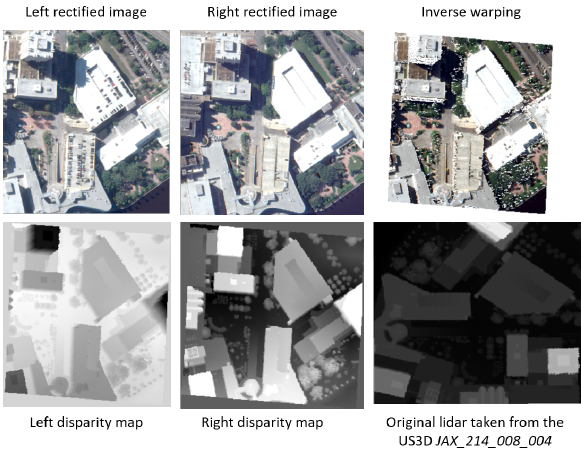
Figure 5. Left and middle: Outputs of our ground truth pipeline produced from the US3D JAX 214 008 004. Right: inverse warping and input lidar raster. This pair obtains the worse mean disparity error on buildings class according to SIFT (0.71 pix). Time discrepancy is visible on roof tops and a little on ground. Top left building in the left disparity map also shows an example of fac¸ade reconstruction from the nadir lidar.